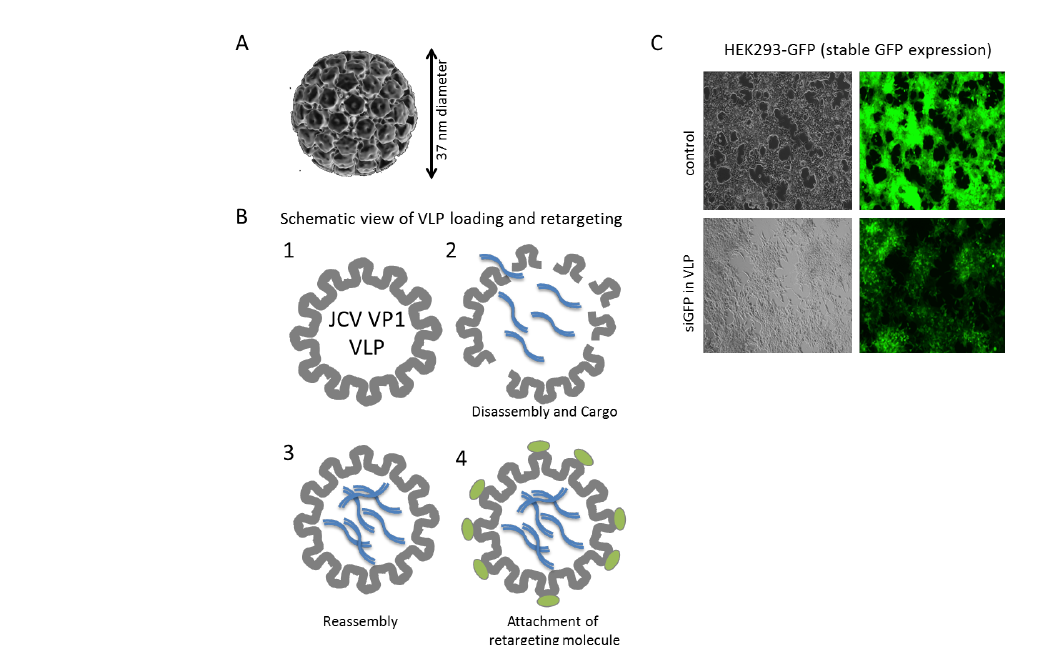
Figure 2. Virus-like particles (VLPs) of the human polyoma JC virus. Recombinant major capsid protein VP1 of the JC virus spontaneously forms VLPs. (a) 3-D reconstitution of electronmicrographs displaying the highly symmetric VLPs that are assembled from 72 pentameric capsomers. (b) A schematic overview of steps to utilize the VLPs for targeted delivery. Cargos are loaded after dissociation of the purified VLPs and reassembled to pack the load (e.g., DNA or synthetic RNA molecules). Target specificity can be achieved by attaching ligands to the outer VLP surface (step 4) to facilitate cell internalization via binding-exposed cell markers. Stably GFP expressing human HEK293 cells were treated with retargeted VLPs carrying either a non-cognate siRNA (control) or siRNAs targeting the GFP-mRNA (siGFP). A drastic reduction of the GFP expression can be seen after siGFP delivery in VLPs, while the cells treated with the control formulation remain unaffected and display homogenous and strong GFP expression. (c) Fluorescence assays to demonstrate targeted delivery of siRNA into HEK 293